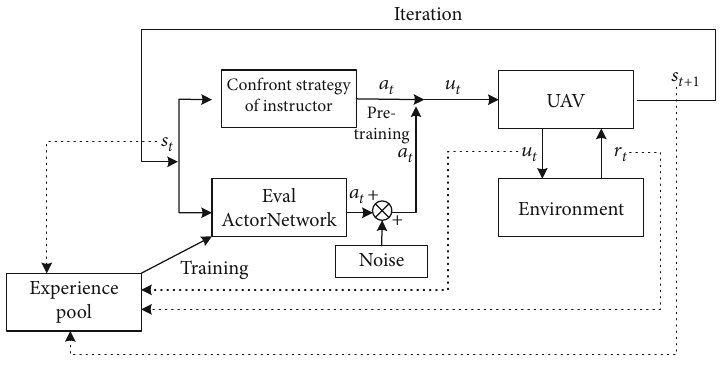
Figure 4: O ffl ine training and exploration process of Table 1: Table of training hyperparameter.